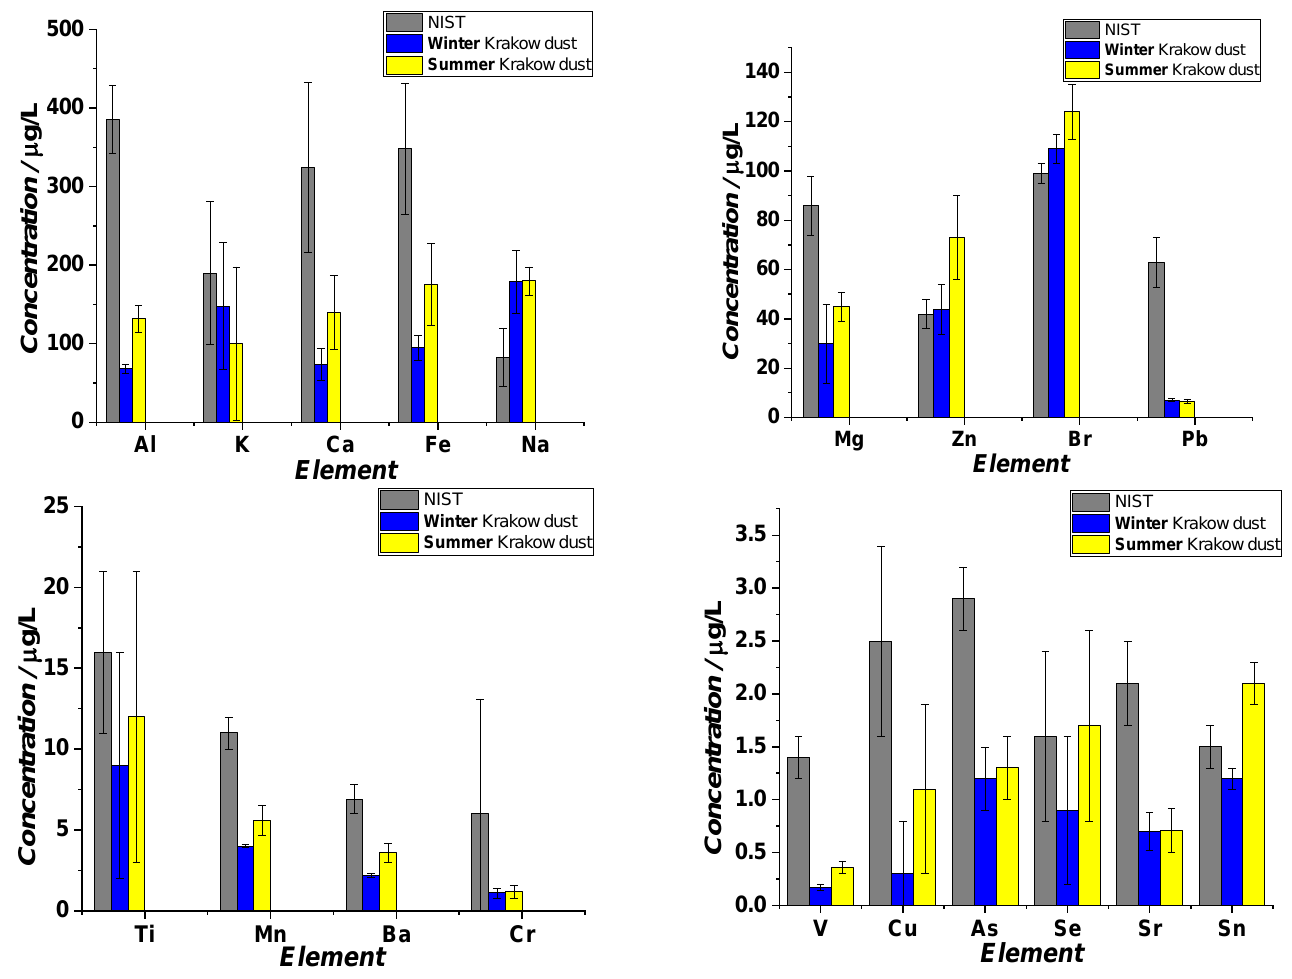
Figure 2. Elemental content of NIST PM, Krakow winter, and Krakow summer dust obtained by ICP MS analysis. Presented values are average values from measurements of six samples using the method Total Quant.